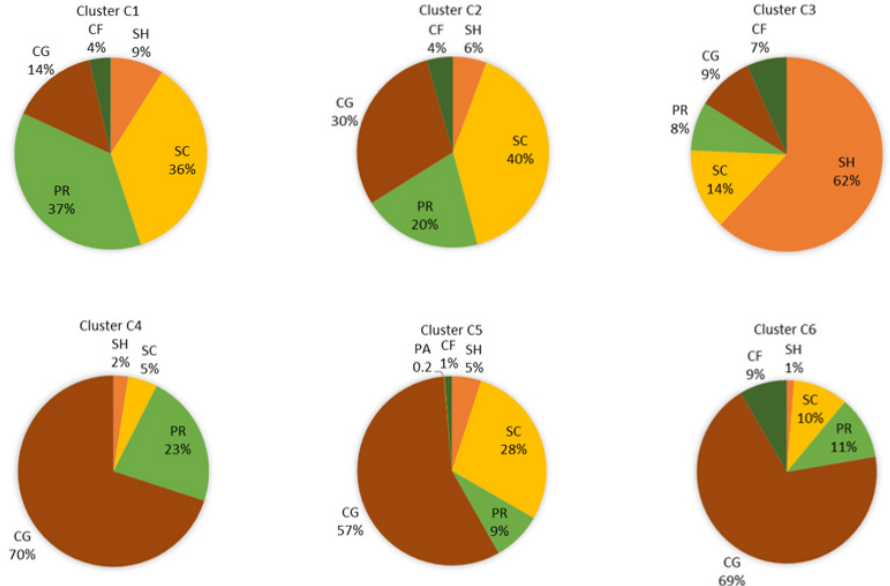
Figure 7. Functional feeding group distribution per cluster for community-based clustering analyScheme 6. CF, SH, SC, PA, PR, and CG refers to the collector-filterers, shredders, scrapers, parasites, predators, and collector-gatherers, respectively. Cluster 1 represents the leftmost cluster, while Cluster 6 represents the rightmost cluster in Figure 6.